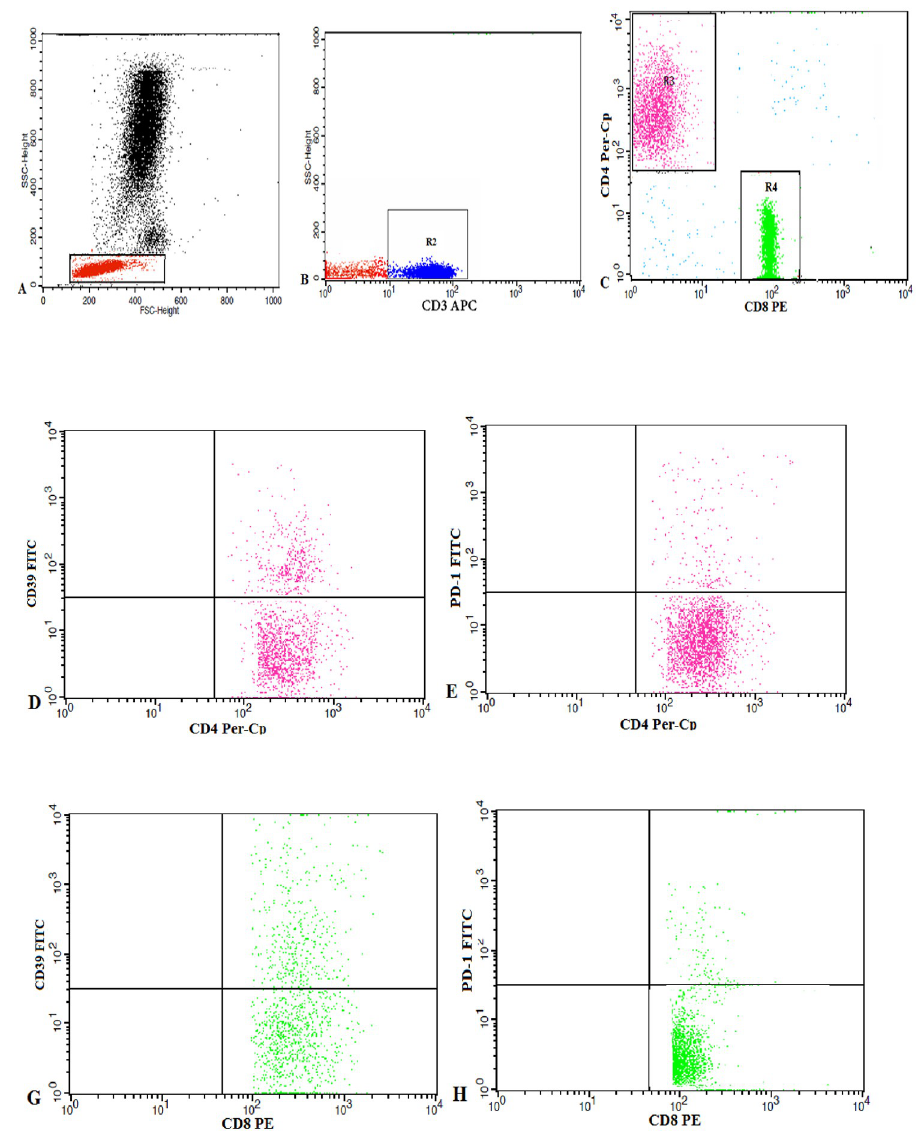
Fig 1. Flow cytometric analysis of CD39 and PD1 expression by the T Lymphocyte subsets. A: The lymphocyte population was gated from peripheral blood mononuclear cells by drawing (R1) based on the forward/side scatter characteristics. B, C: CD3 expression was analysed on the gated lymphocytes, and the CD3 + cells were selected by (R2) for further analysis based on CD4 and CD8 expression. (R3) and (R4) represent the regions used to choose the CD4 + andCD8 + T cells, respectively. D-H: Dot plots representing CD39 and PD1 expression by CD4 + andCD8 + T cells.